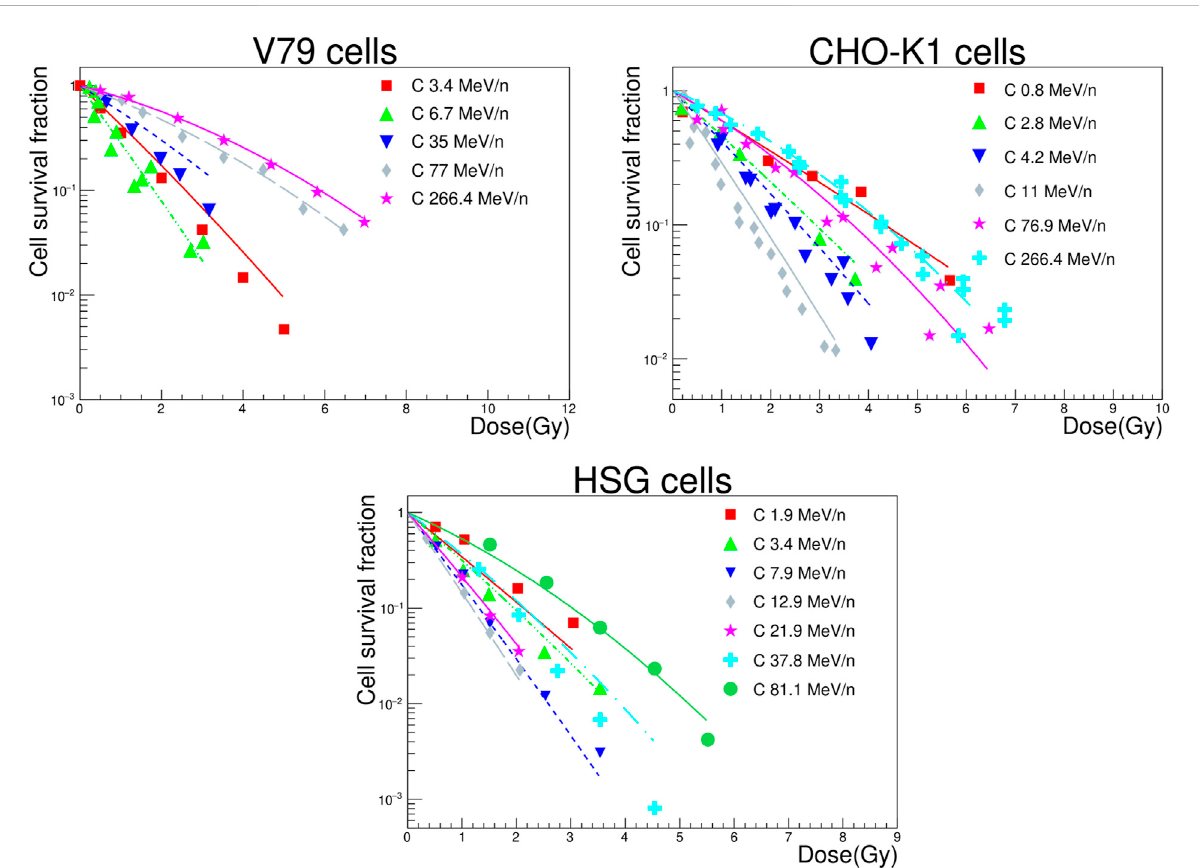
FIGURE 8 Survival curves for V79, CHO-K1 and HSG cells irradiated by carbon ions of various energies. The NanOx model predictions are represented by the solid and dashed lines. The experimental measurements taken from the PIDE project database [37] ( fi lled symbols) are shown for comparison.